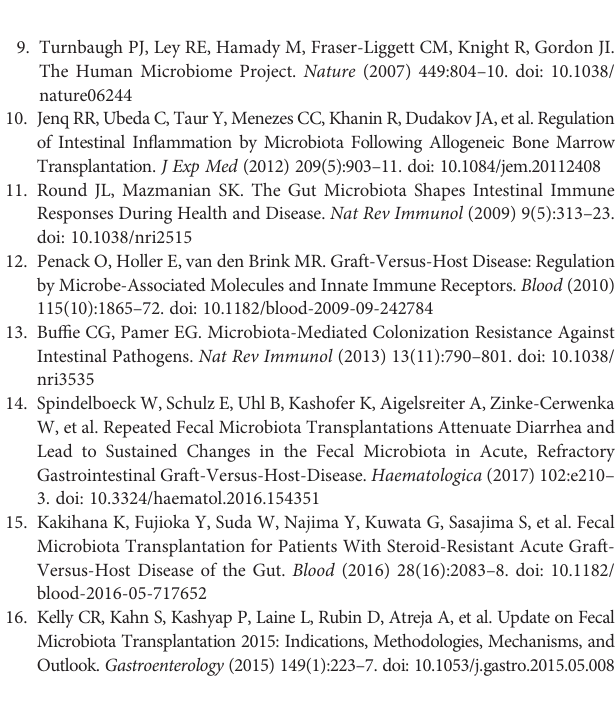
Supplementary Figure 1 | Analysis offecal microbiota in donor and 10 patients. (A) The diversity of fecal microbiota(Shannon ’ s diversity index) change in pre-FMT (0D) and post-FMT(7D) samples. (B) Relative abundance of proteobacteria and fi rmicutes in donor group, pre-FMT(0D) and post-FMT(7D) samples. *p < 0.05. (C) Relative abundance of bacteroidetes in pre-FMT(0D) and post-FMT(7D)